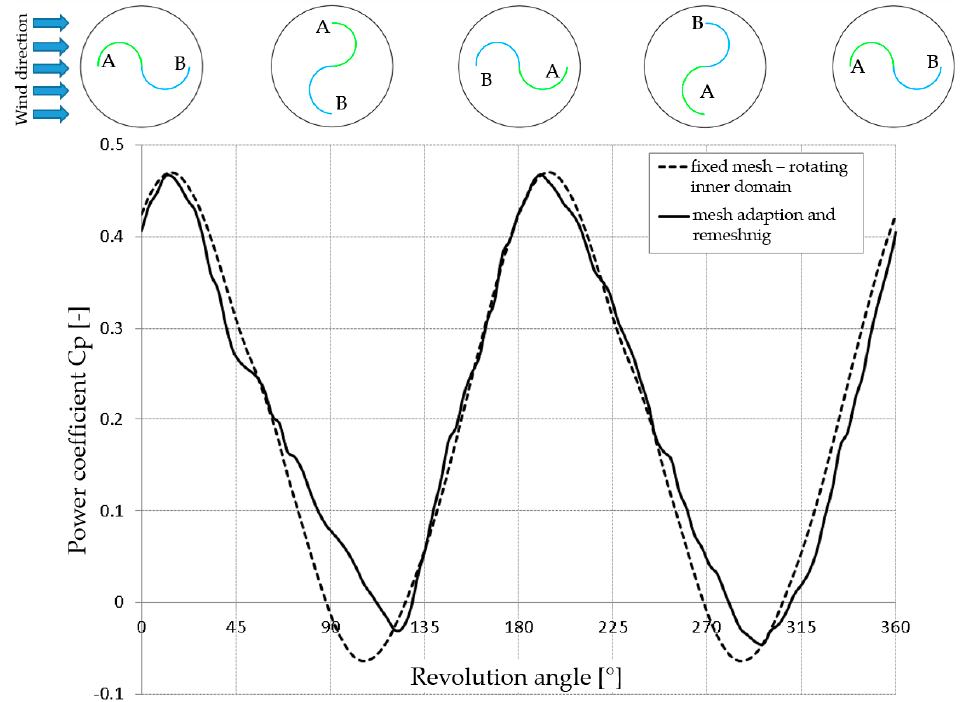
Figure 5. Comparison of the power coefficient Cp for one revolution of the non-deformable rotor from simulations with the rotating inner domain and the deformed/remeshed one. Subsequent positions of the turbine illustrated in the schemes above the graph correspond to the turbine revolution angle.